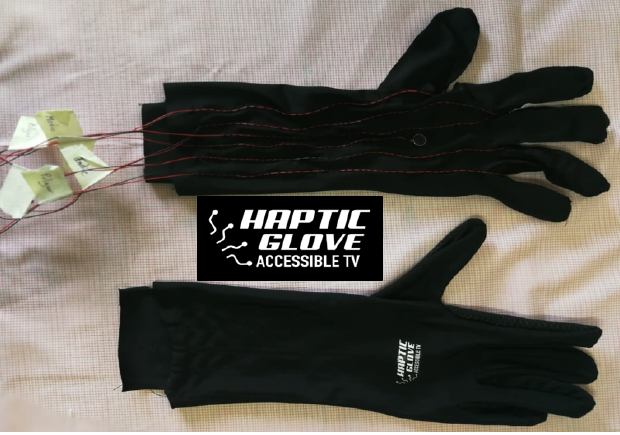
Figure 9. Haptic glove control board case.